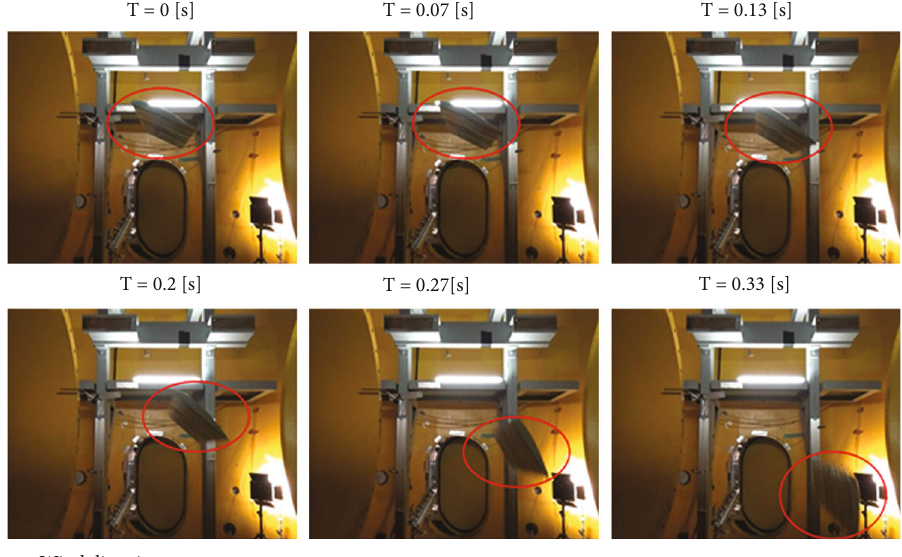
Figure 15: The time series pictures of test model falling down to the back at RA of 3